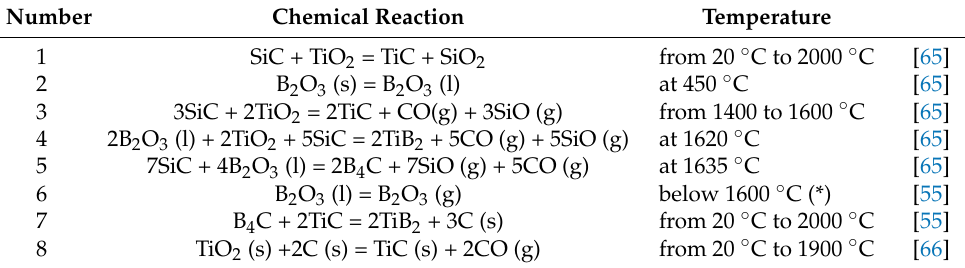
Table 4. Possible chemical reactions during the sintering of the SiC-TiB 2 -TiC system.